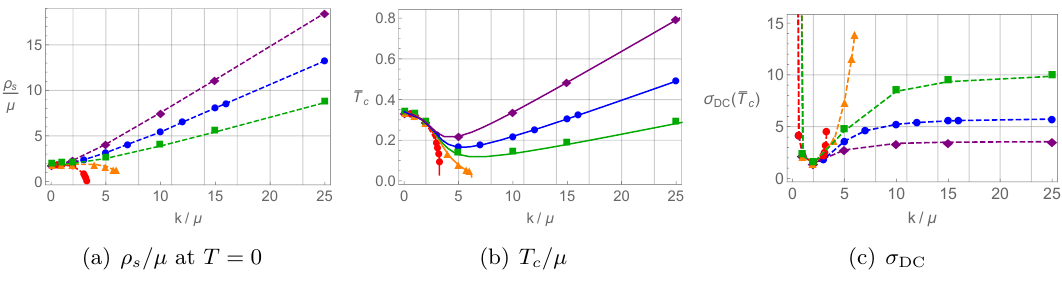
8 9 10 12 , 1 √ , 1 √ , 1 √ ) (red, orange, green, blue, 10 10 10 10 3 3 3 3